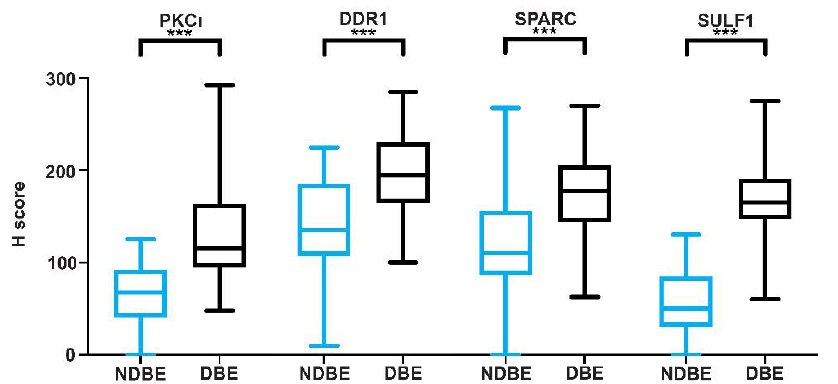
Figure 2. The comparison of immunohistochemistry results between dysplastic Barrett’s esophagus and non-dysplastic Barrett’s esophagus. DBE: dysplastic Barrett’s esophagus; NDBE: non-dysplastic Barrett’s esophagus. *** p value < 0.0001. Table 2. Immunohistochemistry results of four targets in non-dysplastic Barrett’s Table 1. Immunohistochemistry results of four targets in dysplastic Barrett’s esophagus.